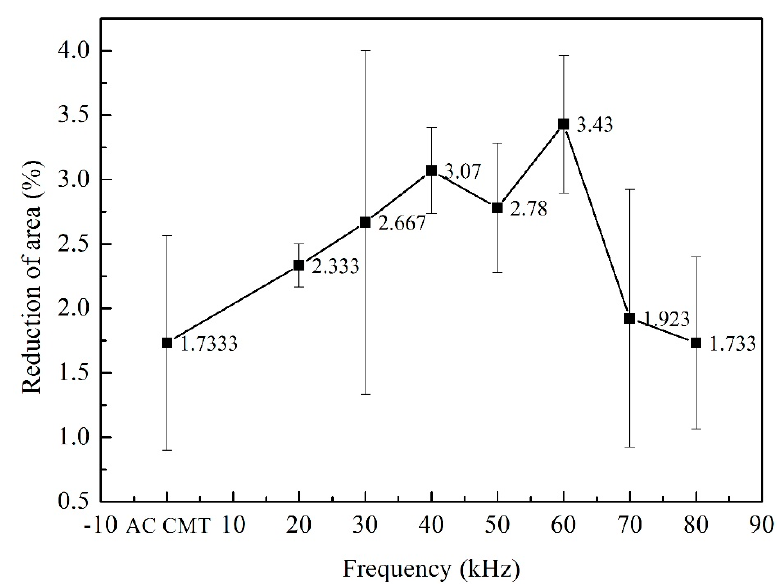
Figure 12. The reduction of area of joints welded by AC CMT and AC CMT coupled current at